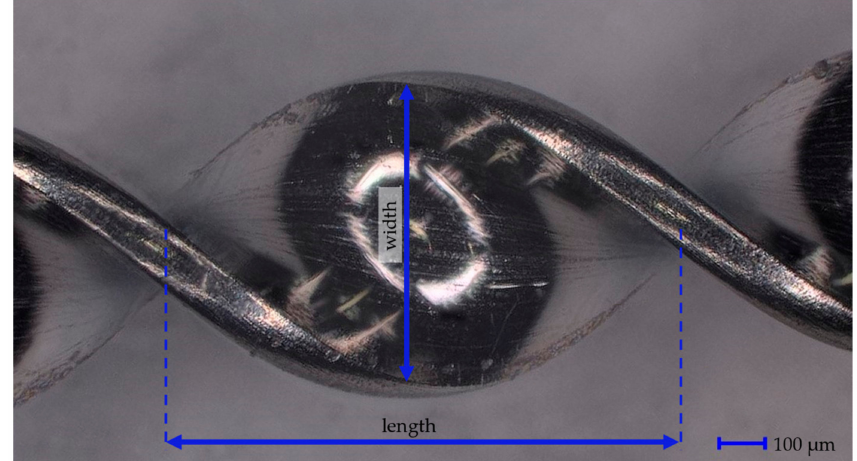
Figure 1. Magnified view of one winding. Captured using 3D-Depth imaging with a digital micro- scope (VHX-970F, Keyence, Japan) at 100 × magnification. Each winding has a length of 1105 µ m ( ± 20 µ m), a width of 800 µ m ( ± 80 µ m), and a thickness of 150 µ m ( ± 15 µ